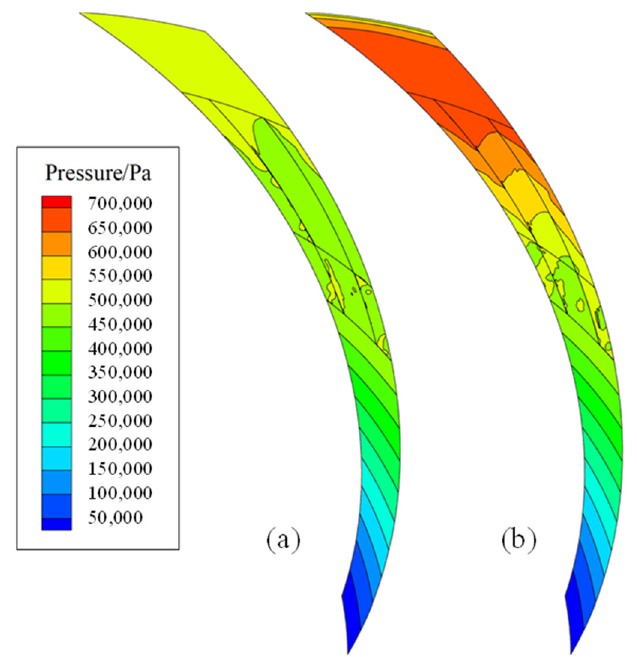
Figure 7. Film pressure distribution of self-pumping hydrodynamic mechanical seals with different diffuser grooves: ( a ) The self-pumping hydrodynamic mechanical seal with an FEDG: ( r k = 34 mm, h ki = h g = 50 μ m, r o = 30.6 mm, N g = 32, γ = 0.5, λ = 0, α = 30°, Δ p = 0.5 MPa, n = 6000 r·min − 1 ); ( b ) The self-pumping hydrodynamic mechanical seal with a CCDG: ( r k = 34 mm, h ki = h g = 50 μ m, r o = 30.6 mm, N g = 32, γ = 0.5, λ = 0.9, α = 30°, Δ p = 0.5 MPa, n = 6000 r·min − 1 ).